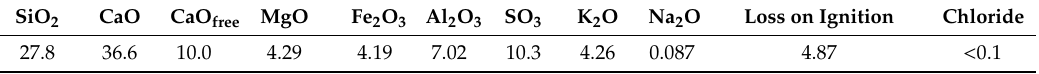
Table 2. Chemical composition of the fly ash (%).